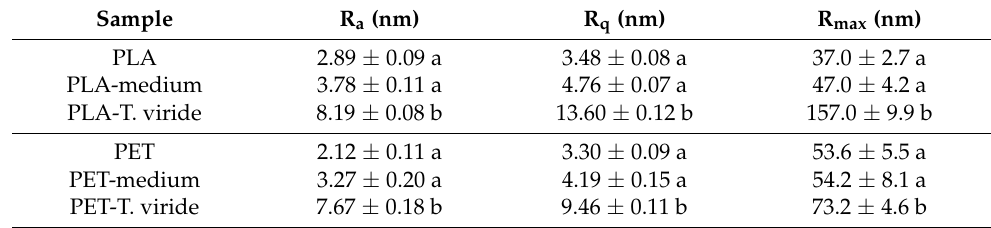
Table 3. Values of roughness parameters of PLA and PET films before treatment, after 3-month incubation in medium, and after 3-month incubation in medium- T. viride GZ1. Values are the means from three independent measurements ± SD. The results were compared separately for each polymer and each parameter, and different letters indicate significant differences ( p <